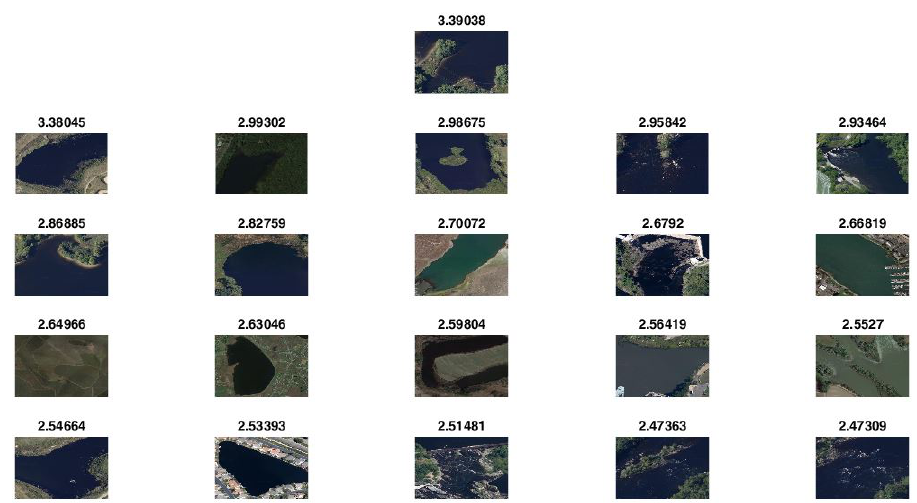
Figure 18. Results of image retrieval for the semantic class “River &